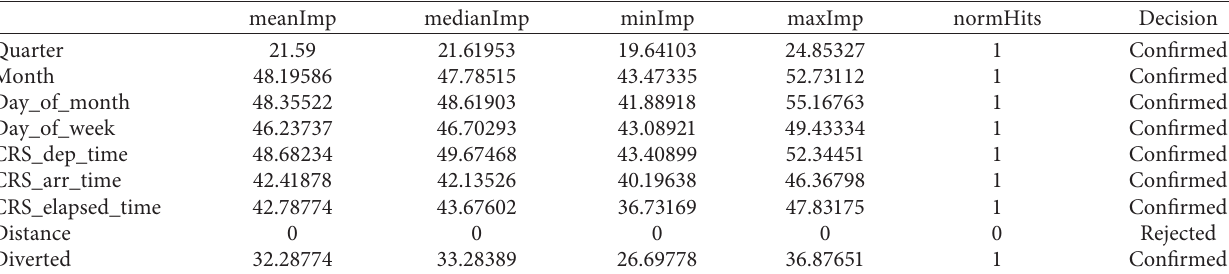
Table 3: Arrival dataset features importance.